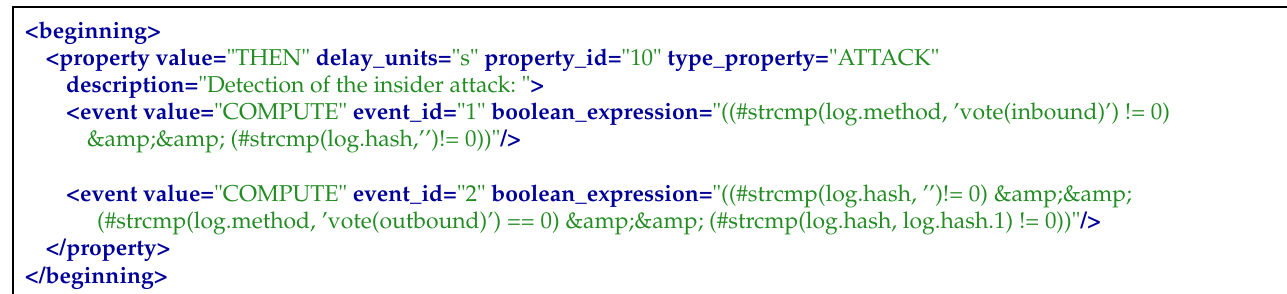
Figure 8. Security rule of the insider attack of the vote example.